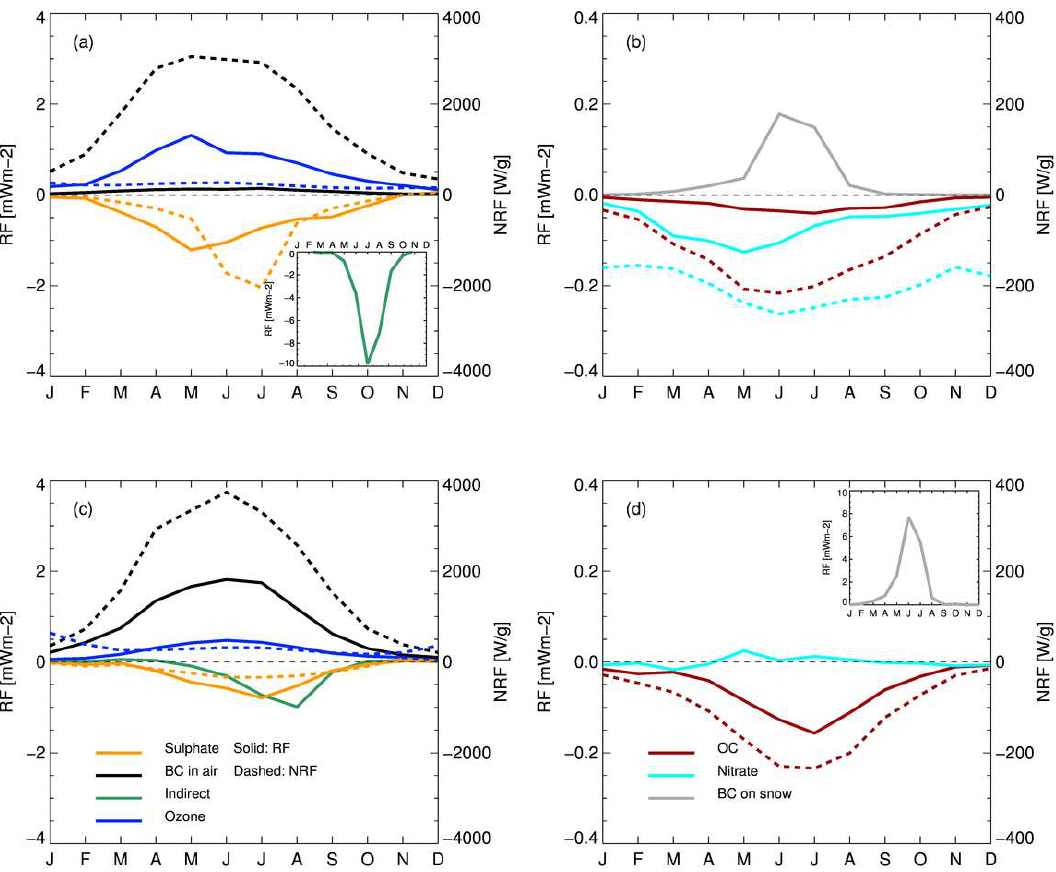
Fig. 8. Seasonal variations of RF (solid lines) and NRF (dashed lines) from sulphate, BC in air, BC on snow, OC, nitrate and aerosol indirect effect. Panels (a) and (b) show shipping, panels (c) and (d) show petroleum. Separation into left and right panels and use of insets is for clarity only. Ozone NRF has units of W / m 2 / DU , and has been scaled by a factor of 10 for clarity.